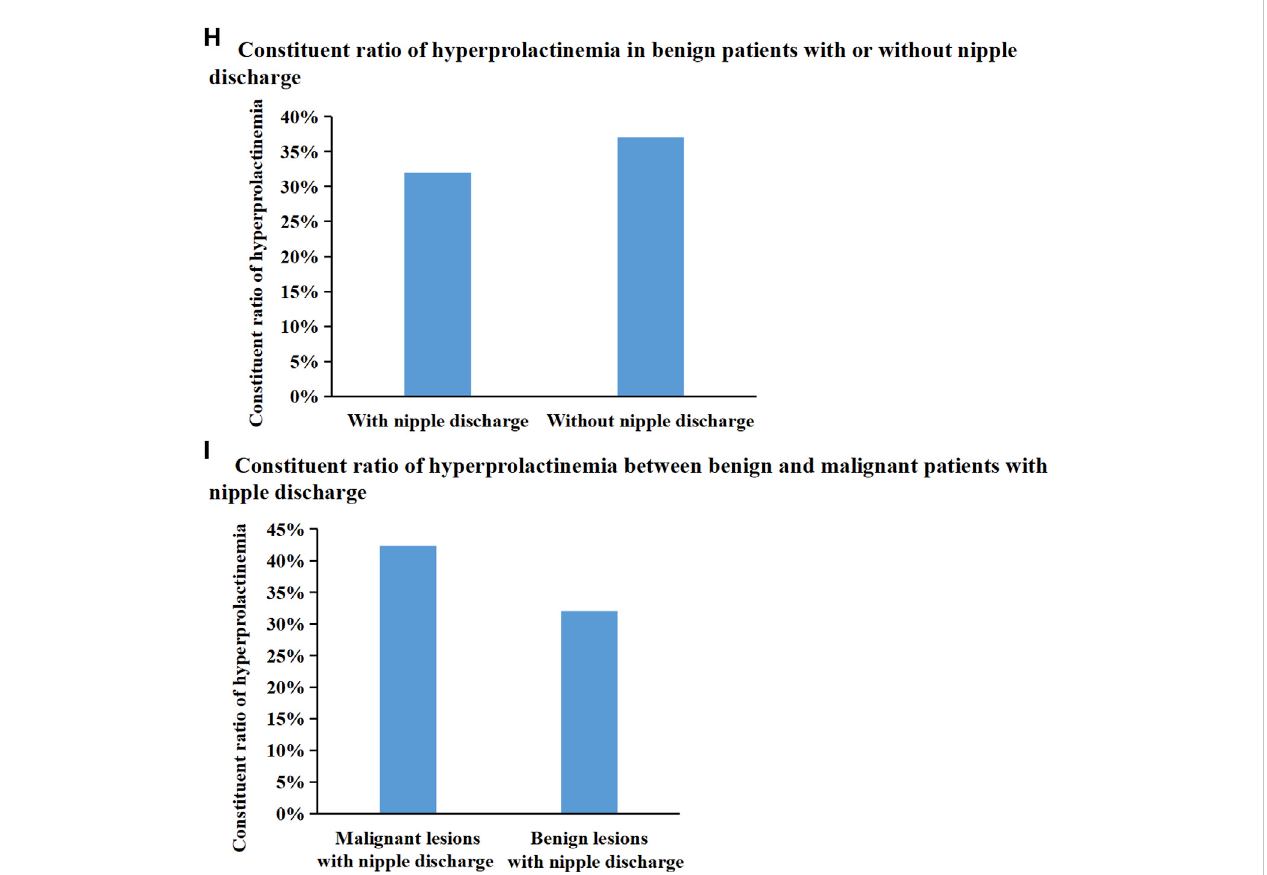
FIGURE 4 (A,B) Proportion of hyperprolactinemia and average prolactin levels were no signi fi cantly different between different BMI groups; (C,D) Proportion of hyperprolactinemia and average prolactin levels were no signi fi cantly different between unilateral and bilateral patients; (E,F) Proportion of hyperprolactinemia and average prolactin levels were no signi fi cantly different in premenopausal women with or without nipple discharge. (G,H) Proportion of hyperprolactinemia were no signi fi cantly different in benign or malignant patient subgroup with or without nipple discharge. (I) Proportion of hyperprolactinemia were no signi fi cantly different between benign and malignant patients with nipple